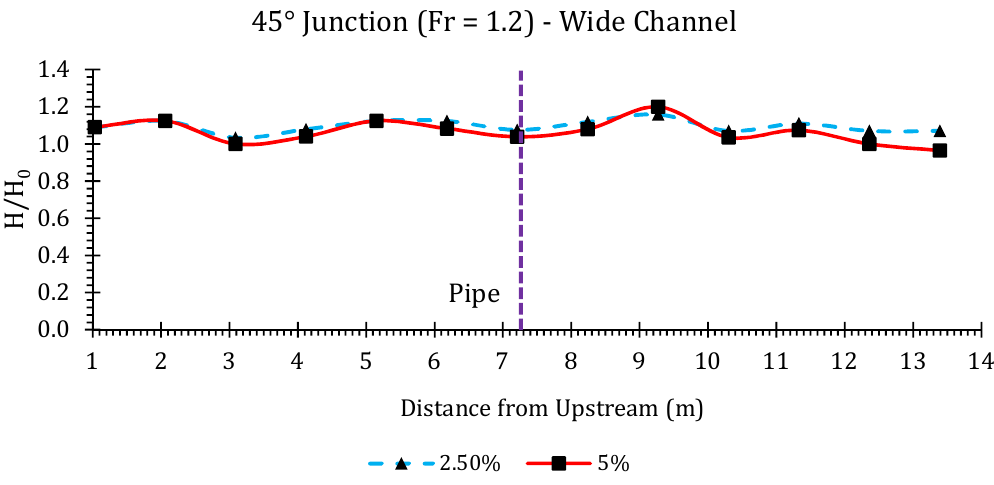
Figure A8. Water height ratios in a 45 ◦ junction for Fr = 1.2 in the wide Figure A8. Water height ratios in a 45° junction for Fr = 1.2 in the wide channel. Figure A8. Water height ratios in a 45° junction for Fr = 1.2 in the wide channel. Figure A8. Water height ratios in a 45° junction for Fr = 1.2 in the wide channel.